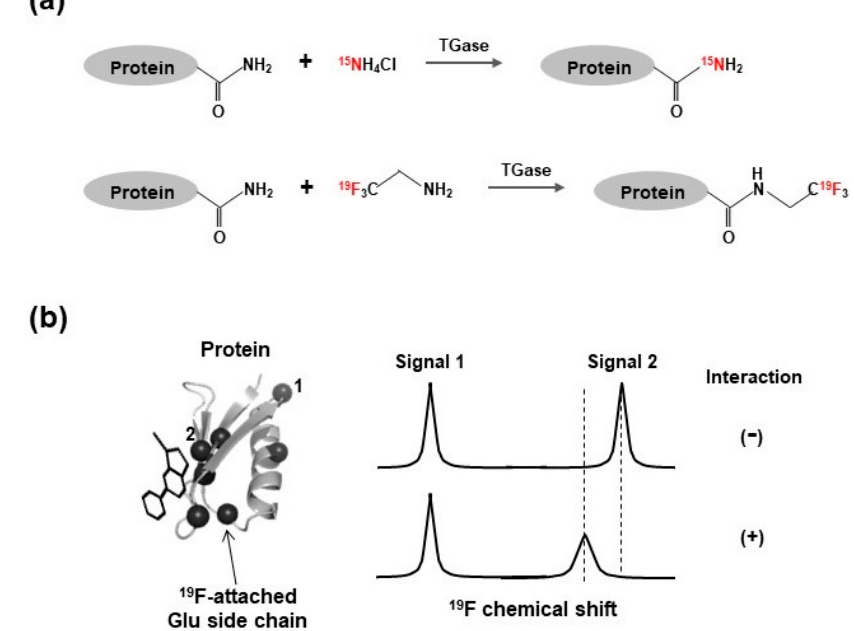
Figure 5. ( a ) Schematic diagrams of enzymatic 15 N- and 19 F-labeling of γ -carboxyamide groups of glutamine residues of target protein. 15 N- and 19 F-labeled atoms are colored in red; ( b ) Black spheres on the protein indicate position of 19 F-labeled γ -carboxyamide groups of glutamine residues. Numbers correspond to each 19 F 1D NMR signal on the right panel. Chemical shift changes and signal broadening are observed upon interaction with ligand.